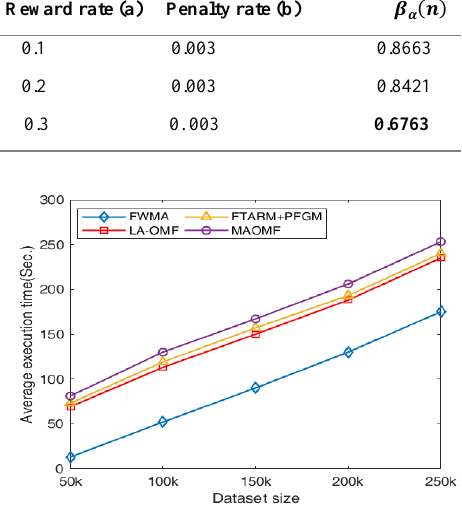
Figure 18. Average execution time with increasing dataset sizes for the CTI